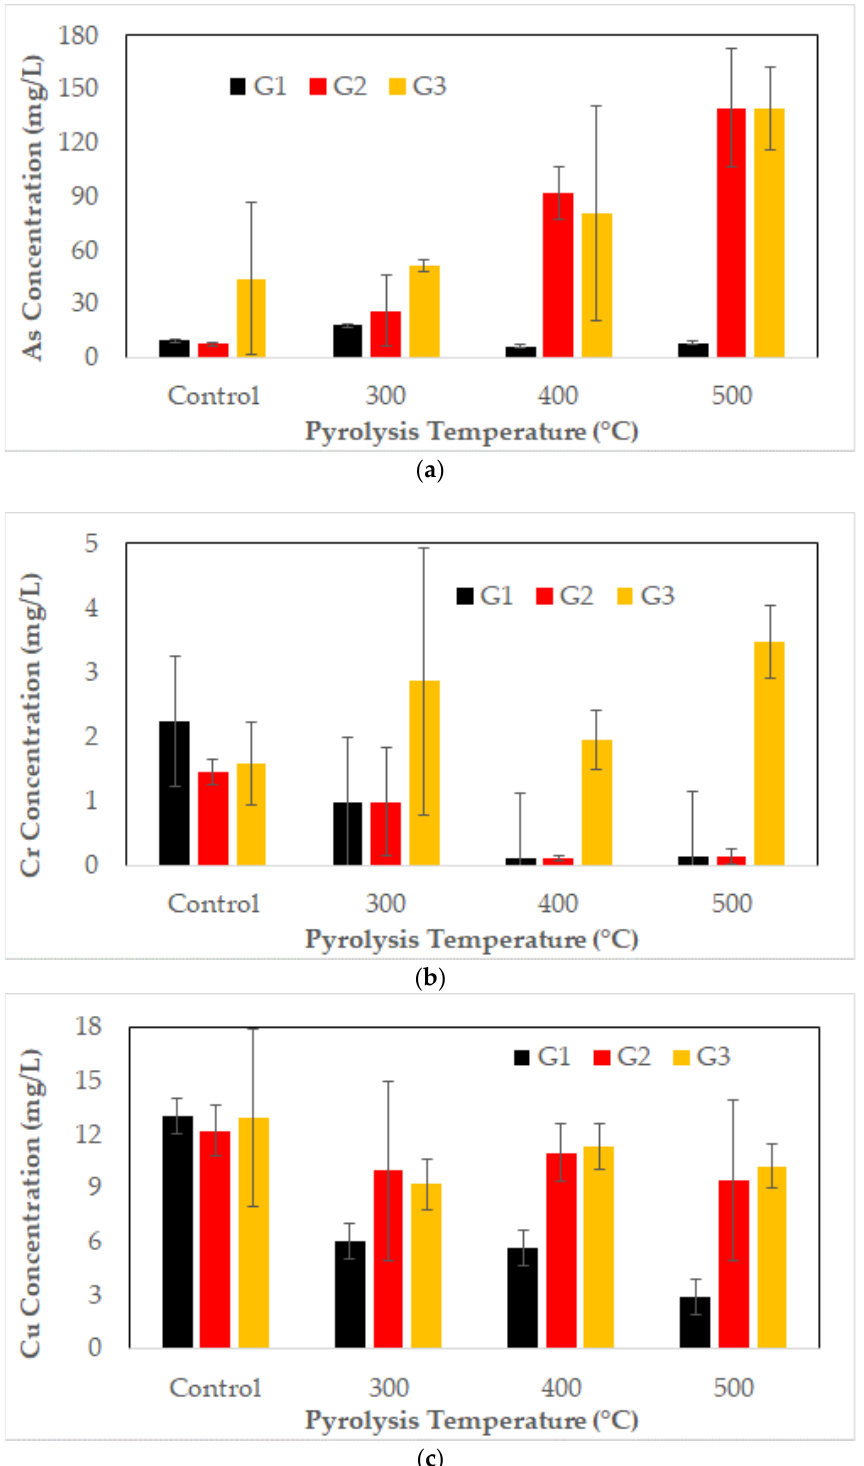
Figure 5. Leaching of arsenic ( a ), chromium ( b ), and copper ( c ) as a function of pyrolysis temperature and particle size. Control is CCA - treated wood.